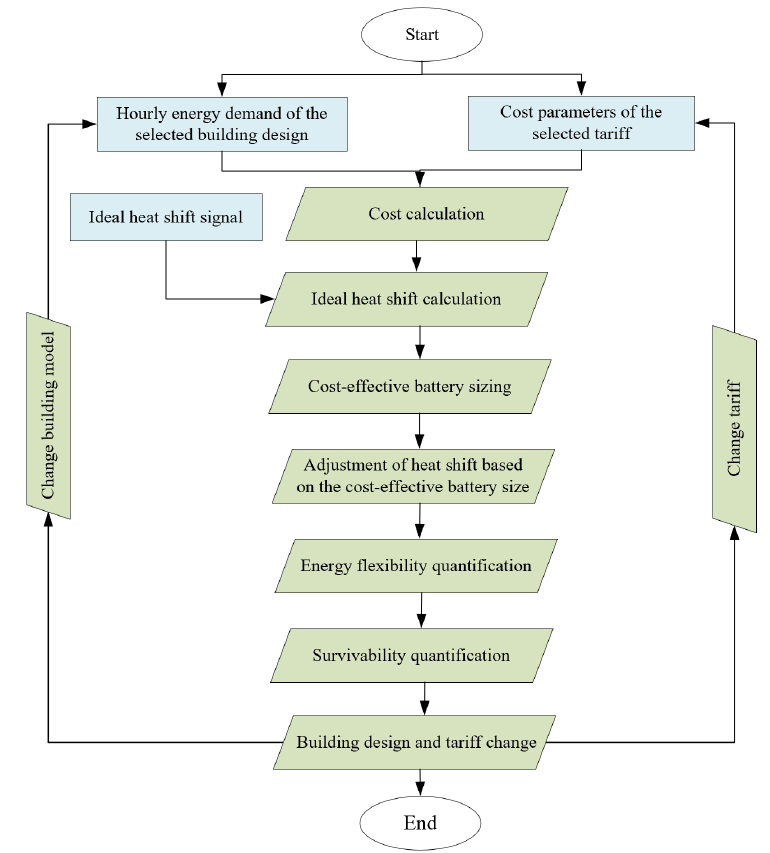
Figure 3. Flow diagram of the algorithm developed in